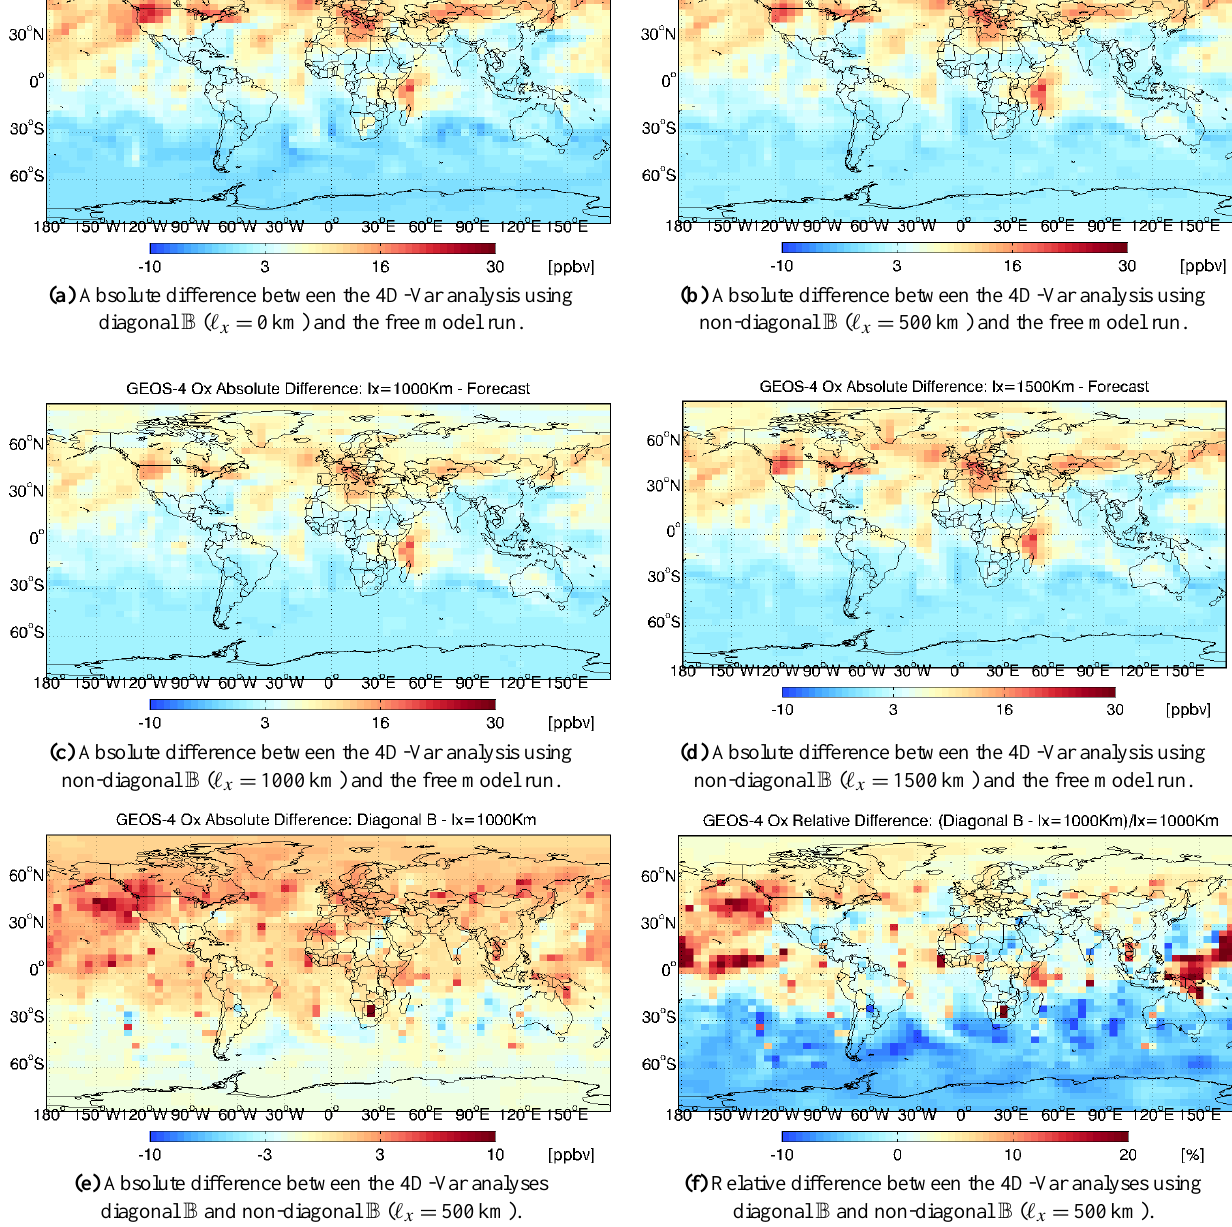
Fig. 5. Differences in global ozone concentrations at 23:00GMT on 31 August 2006 averaged over the first 10 GEOS-Chem vertical levels. (a) – (d) Differences between the 3D-Var analysis fields and the model forecast (solution without data assimilation); the analyses use different correlation lengths between 0km and 1.500km. (e) – (f) Absolute and relative differences between 3D-Var analyses using diagonal and non-diagonal background covariance